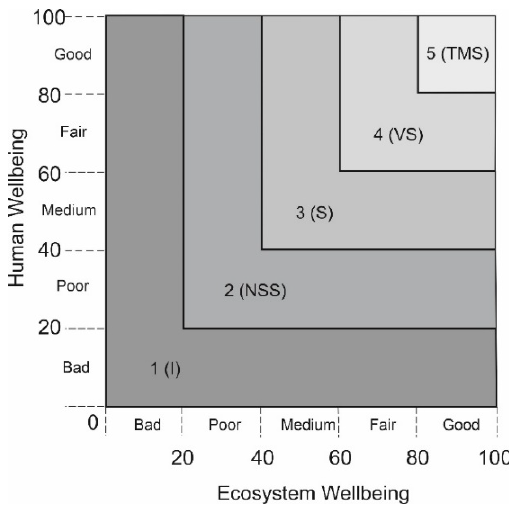
Figure 3. SDG indicator assessment method.